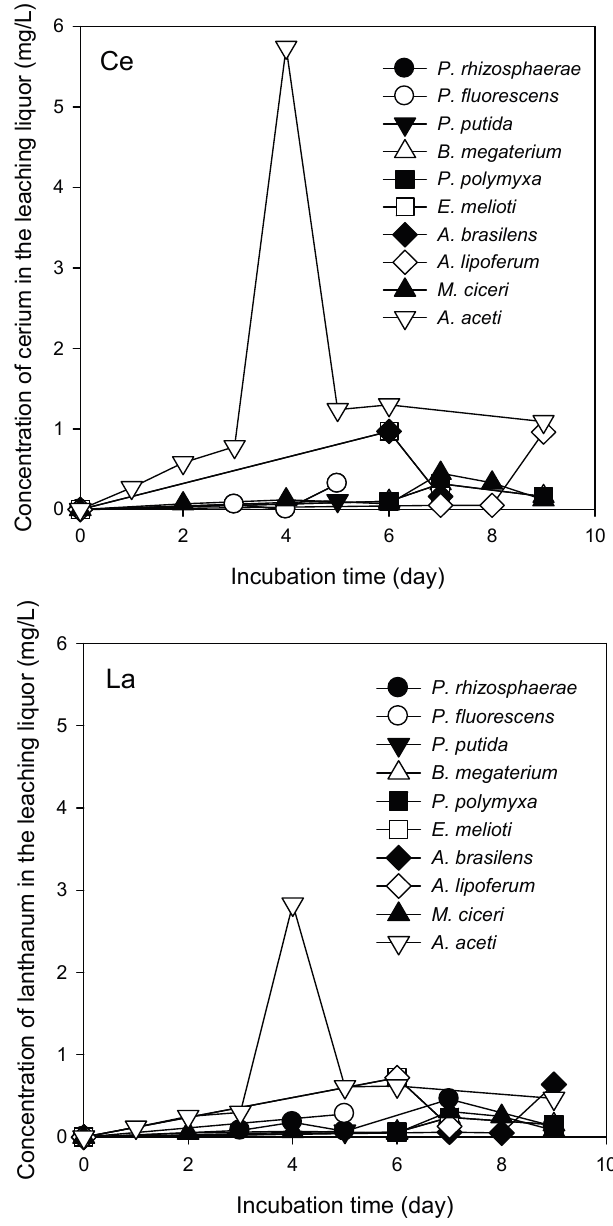
Figure 4. The concentrations of leached cerium and lanthanum from monazite-bearing ore by phosphate solubilizing bacteria (PSB) in Reyes basal liquid medium. Table 3. Elemental compositions of the spots in Figure 5 by scanning electron microscopy/energy dispersive X-ray spectroscopy (SEM-EDS). Spot No. in Figure